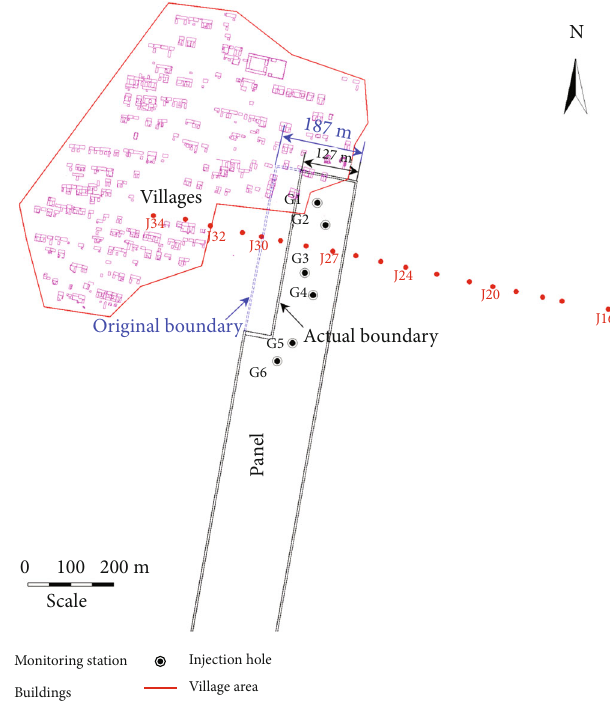
Figure 5: POG technology applied in longwall panel